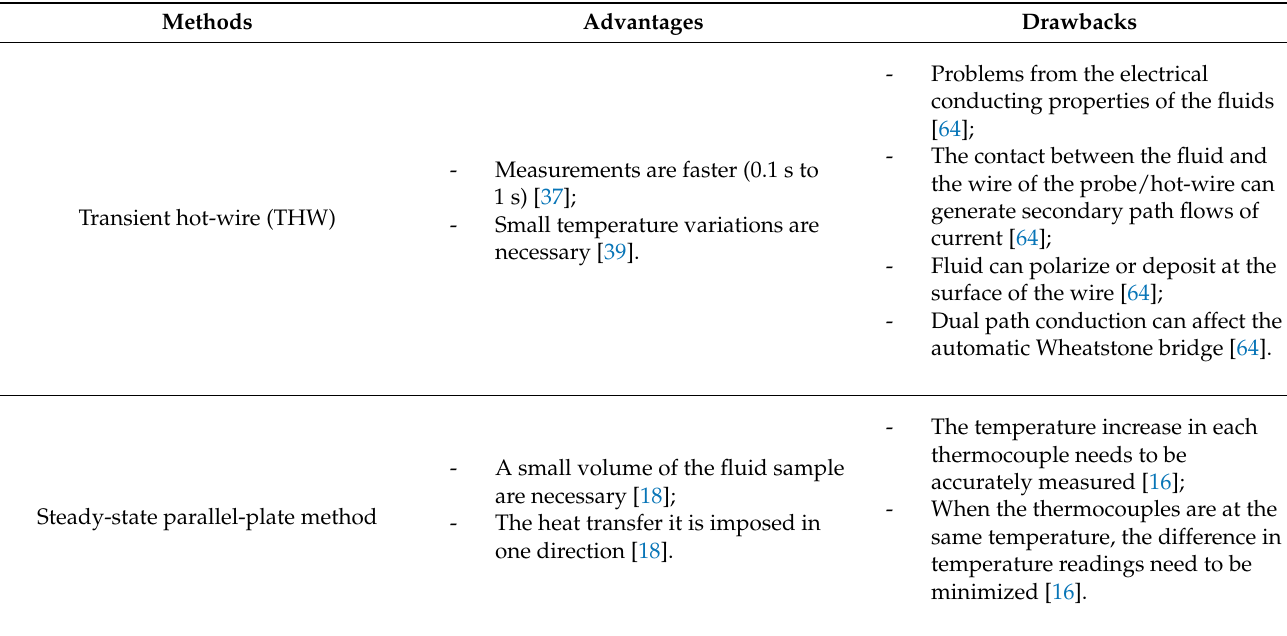
Table 1. Advantages and drawbacks of the most used methods to measure the thermal conductivity of